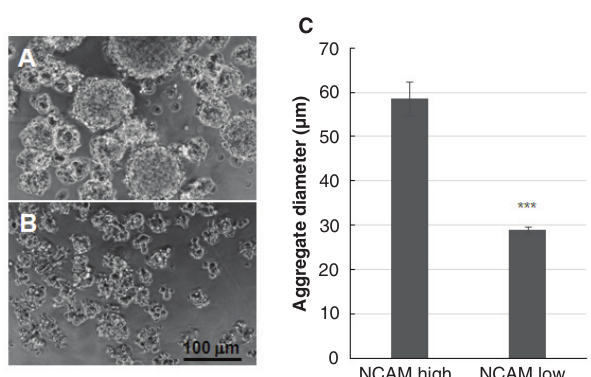
Figure 8. HNK-1 +ve QE8 ENS cell aggregate size is influenced by NCAM levels. A . NCAM-high FACS fraction of HNK-1 +ve ENS cells form aggregates with a wide range of diameters including very large aggregates. B . NCAM-low fraction ENS cells form small misshapen aggregates. C . Histogram of aggregate diameters formed at 18h i n vitro by NCAM-high and NCAM-low ENS cell fractions. Difference is highly